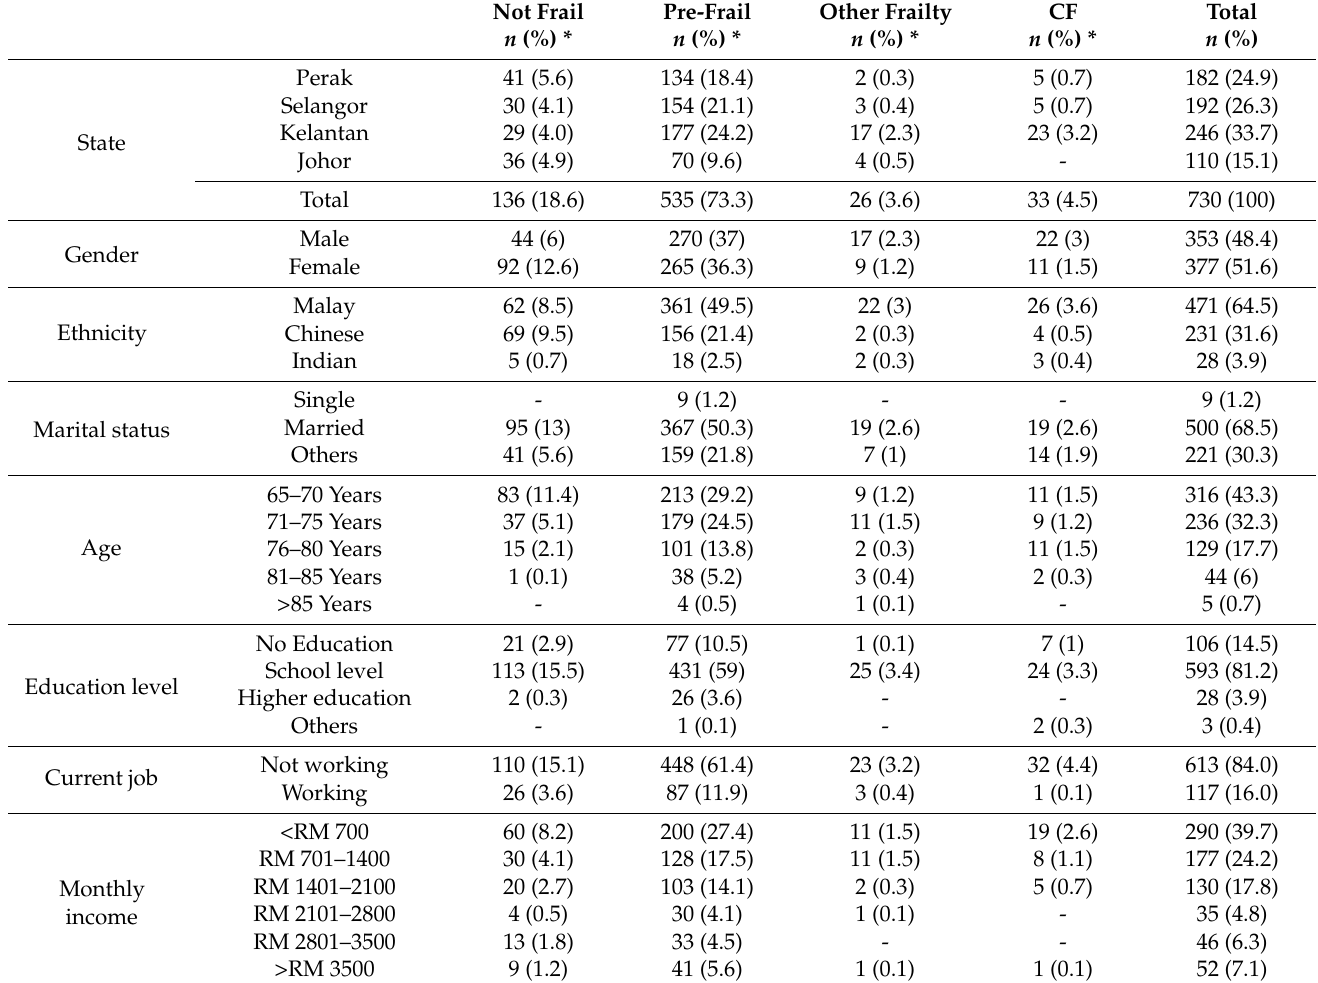
Table 1. Sociodemographic Characteristics of the Study Participants. Not Frail Pre-Frail n (%) * n (%)